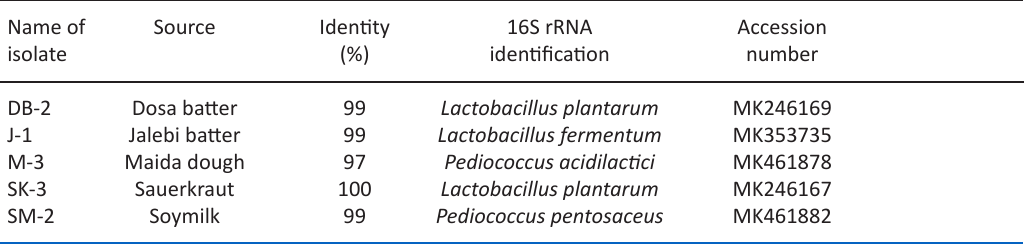
Table 1. Genotyping of screened lactic acid bacterial strains Name